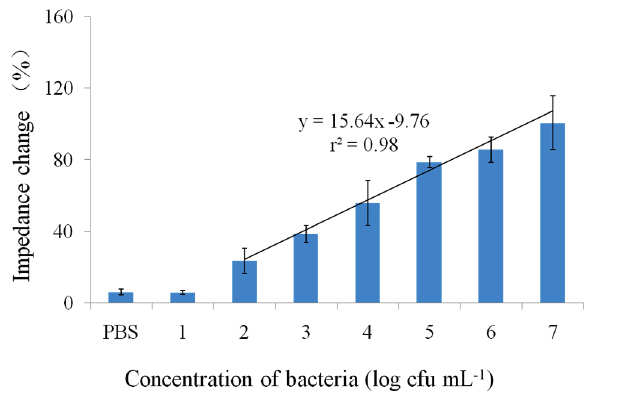
Figure 6. The signal amplification of the immunosensor with WGA solution.